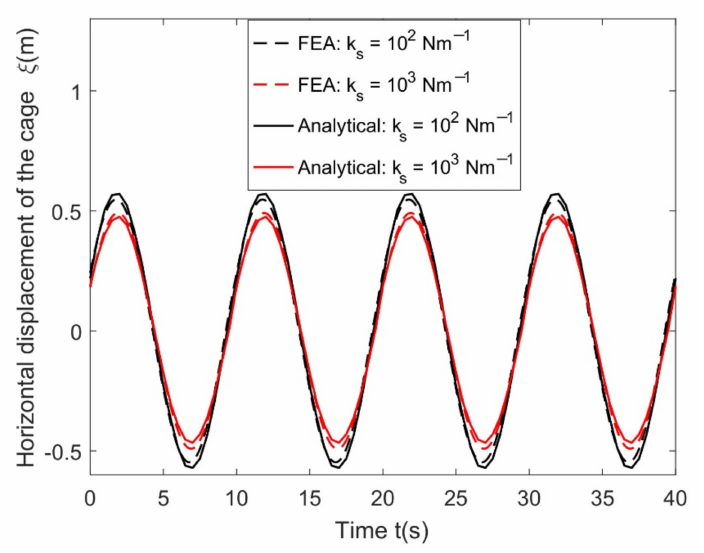
Figure 2. Comparison of the horizontal displacement of a cylindrical flexible cage for different mooring stiffness k s between the numerical finite element analysis (FEA) and analytical simulations with h 2 = 50 m, h 1 = 7 m, and a = 5